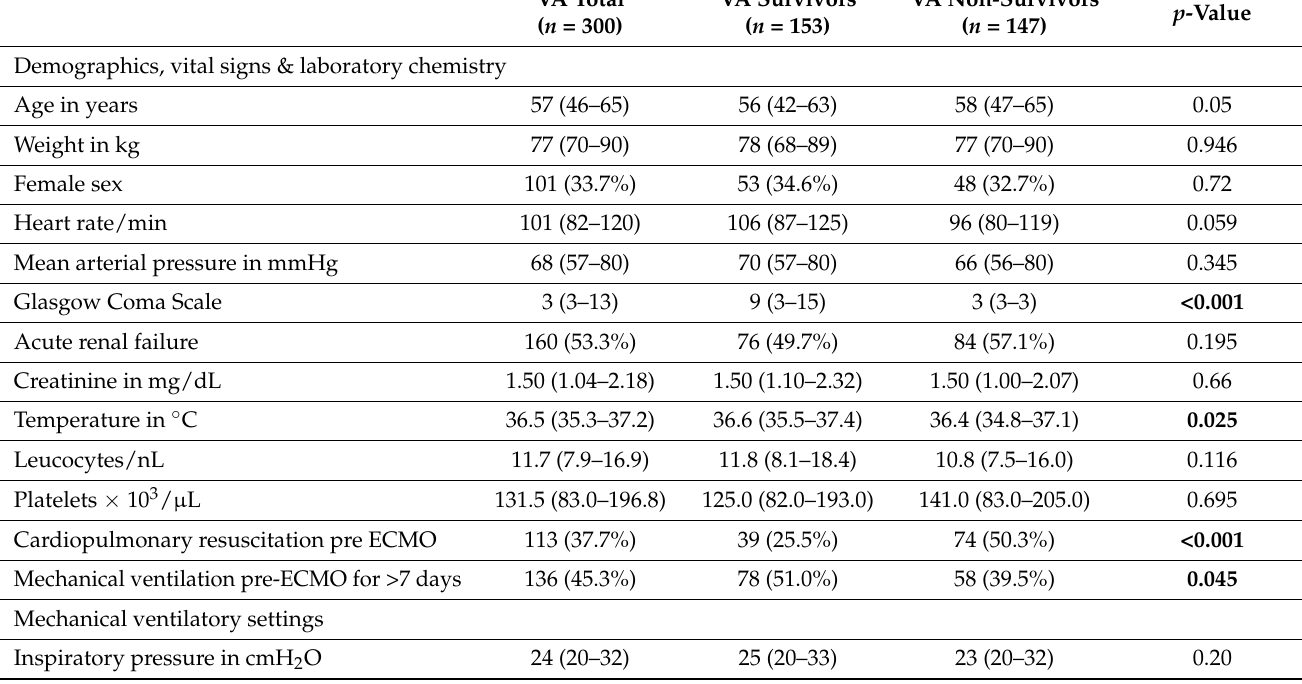
Table 1. Patient characteristics on patients on extracorporeal membrane oxygenation (ECMO) before implantation according to survival (veno-arterial ECMO